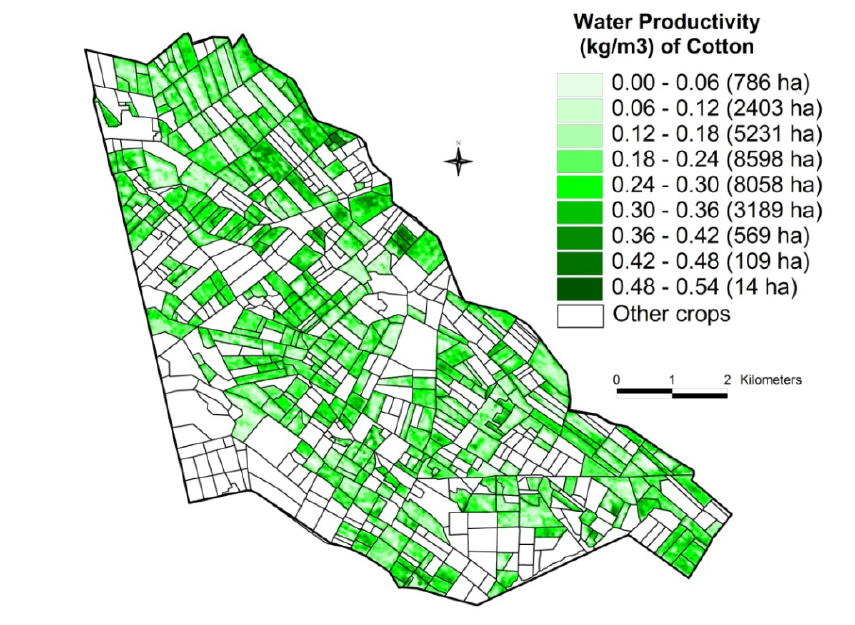
Figure 19. Water productivity map (WPM) illustrated for an irrigated area in Uzbekistan [128]. The the water productivity maps (WPMs) are derived by dividing